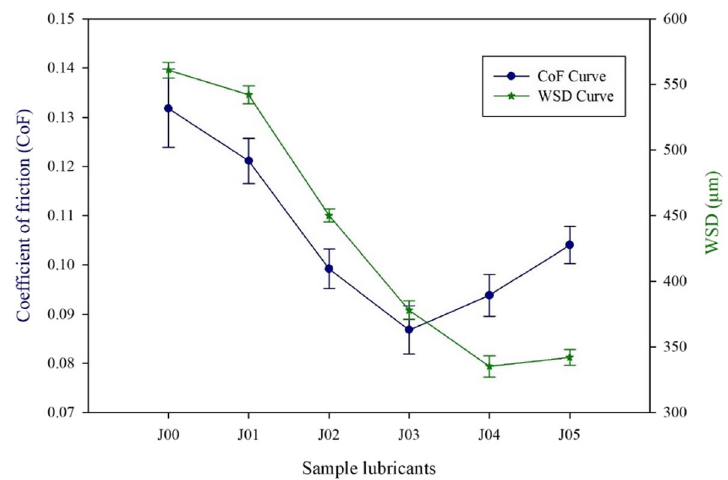
Fig. 8 Friction coefficient and wear scar diameter as a function of additive